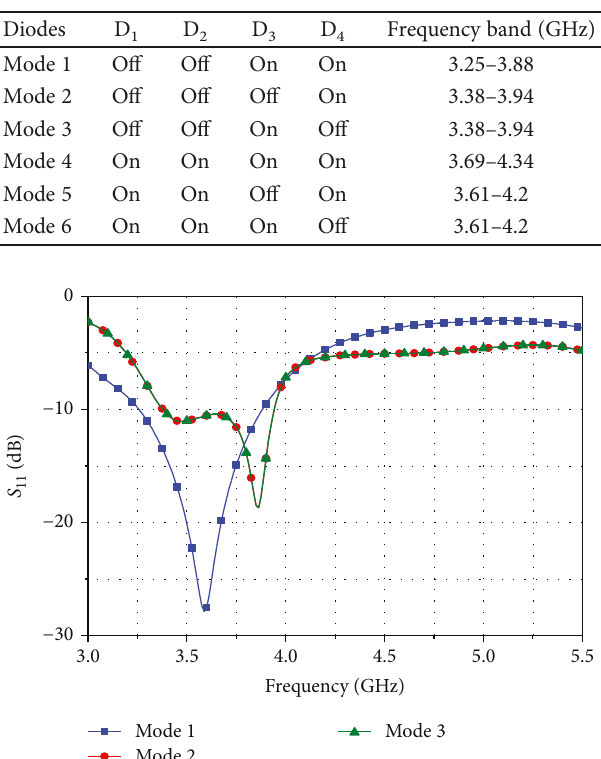
Figure 1: Geometry of antenna. (a) Top view and (b) bottom view (white-radiating slots, light gray-biasing slots, dark gray-biasing strips, and dark block-capacitors and inductors). Table 1: Operation modes of antenna.